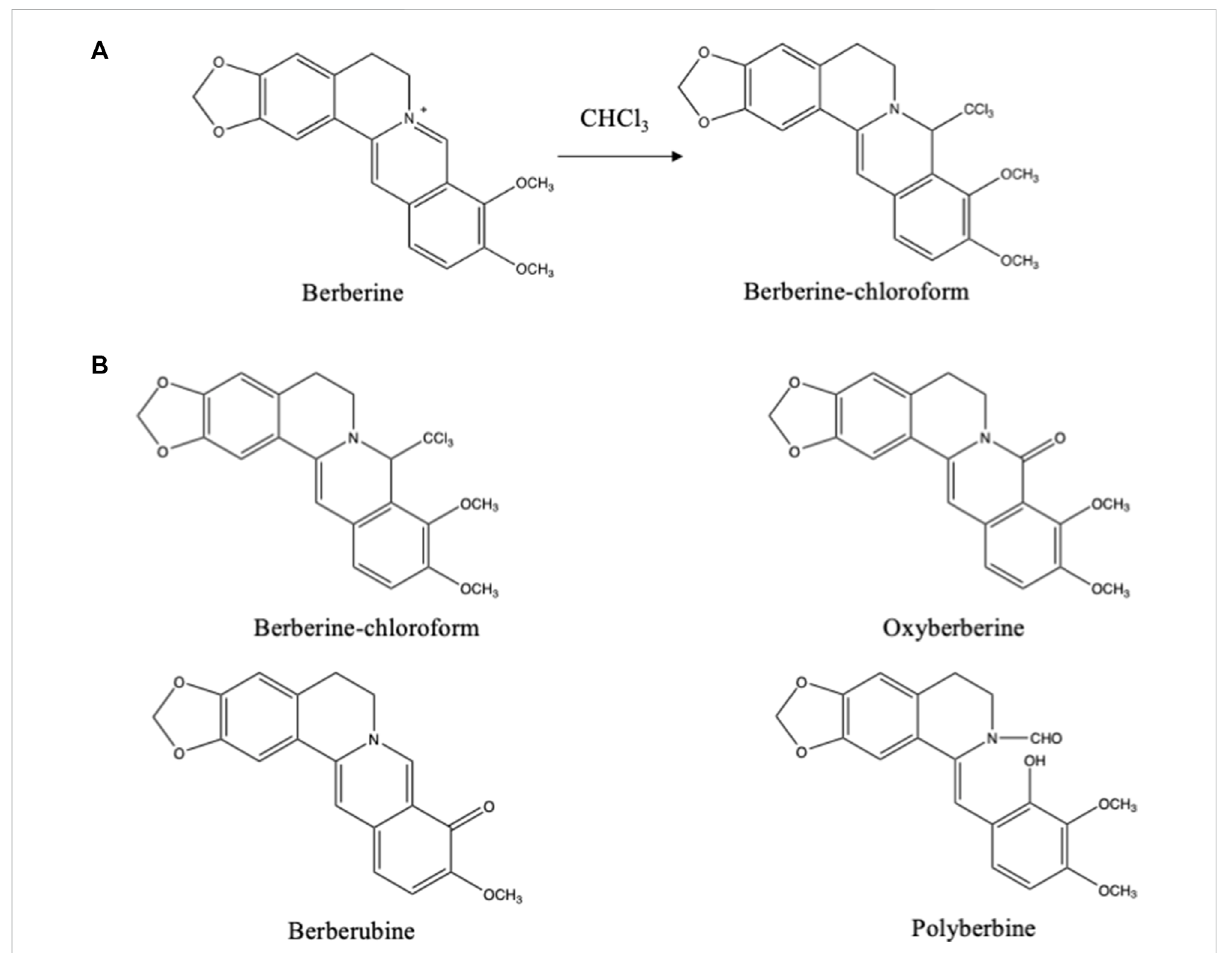
FIGURE 5 (A) Artifact formed from berberine during its isolation using chloroform (Miana, 1973). (B) Artifacts derived from berberine formed